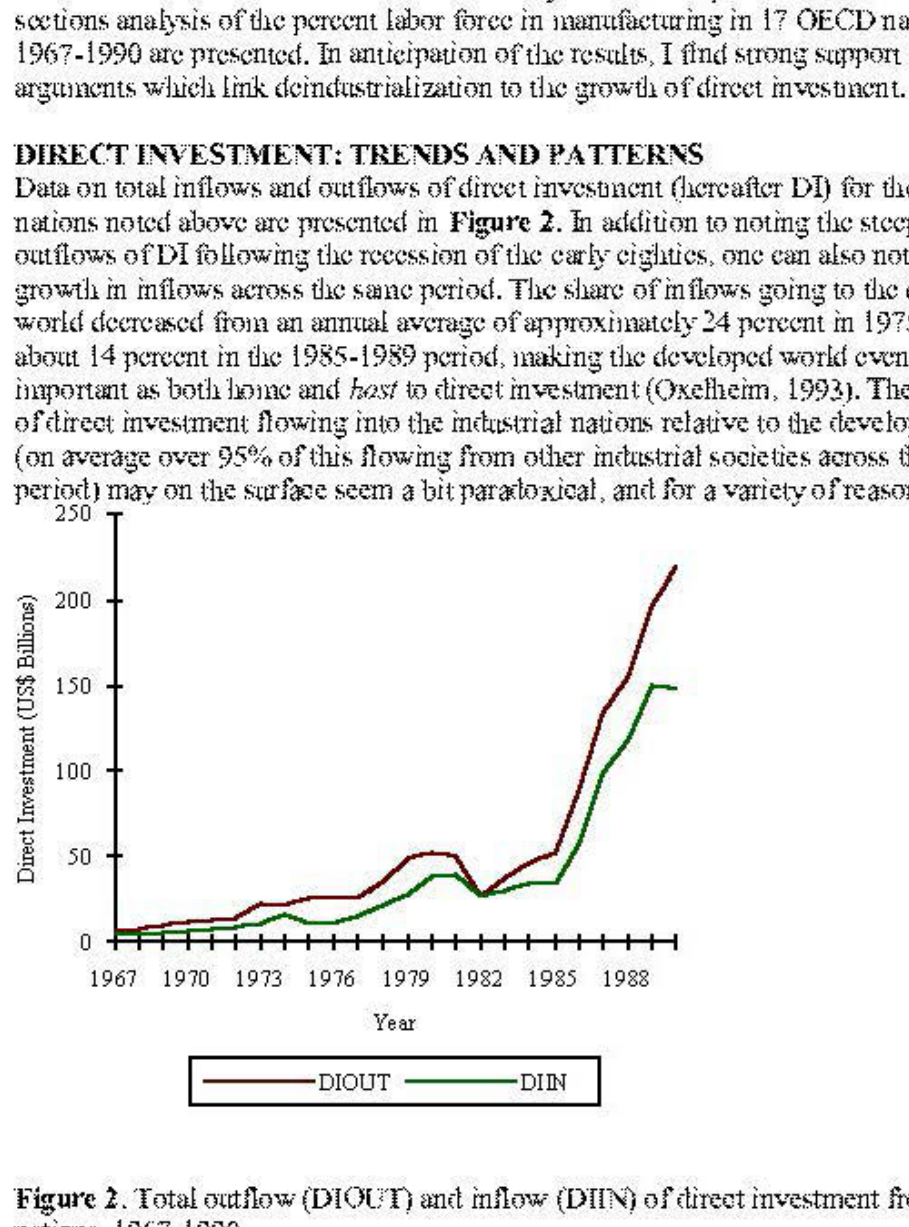
Figure 2. Total outflow (D!OlTD imd inflow (D!IN) of direct investment .fiom 17 OECD nations. 1967-1990. So11rce: l'vff Baiar."e ()fR.:ymer.ts Statisti"s Year&x.1k ( ·"llrioi~,